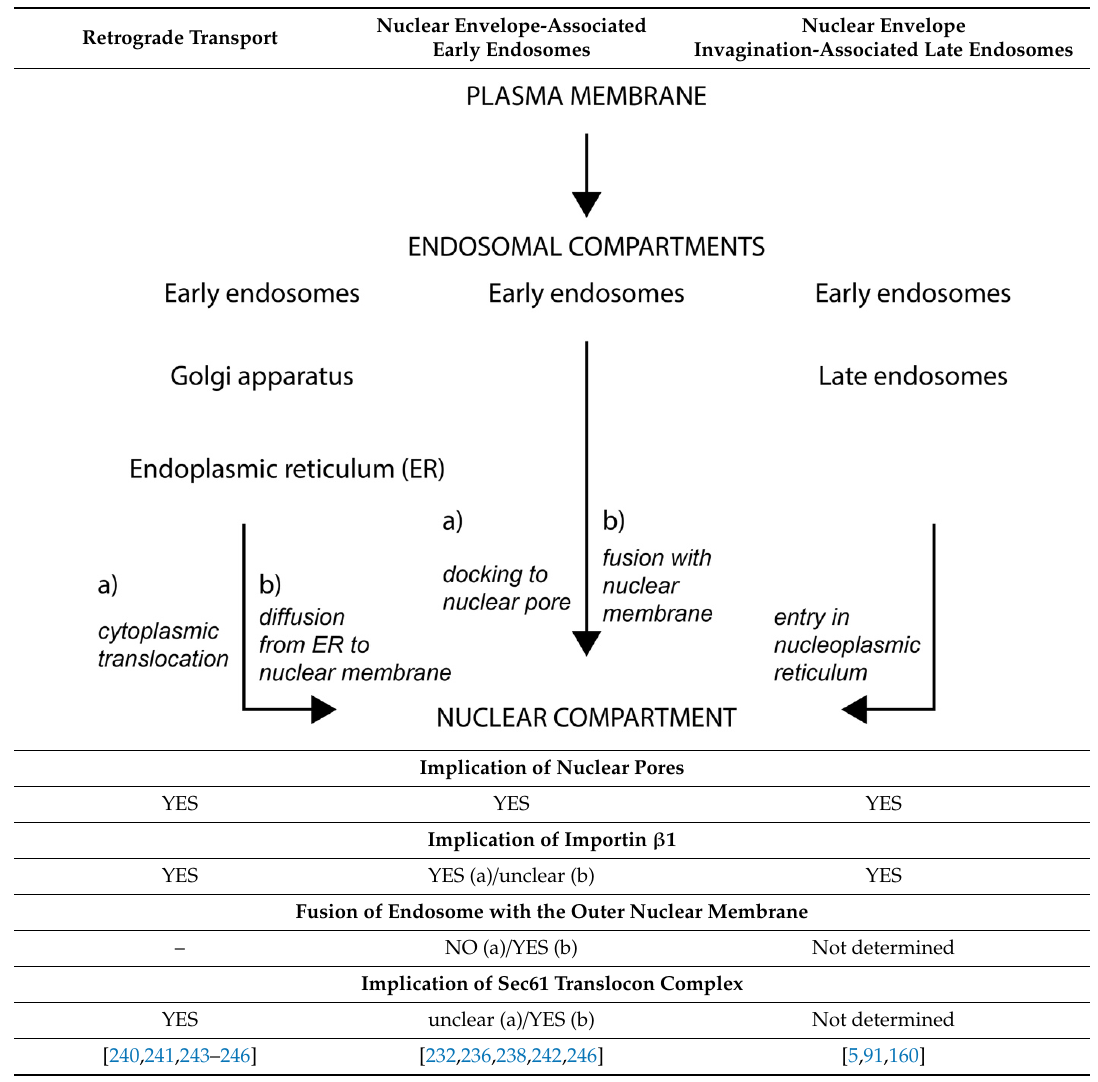
Table 1. Potential pathways of nuclear transport of cell surface proteins present at plasma membrane and / or extracellular membrane vesicles.